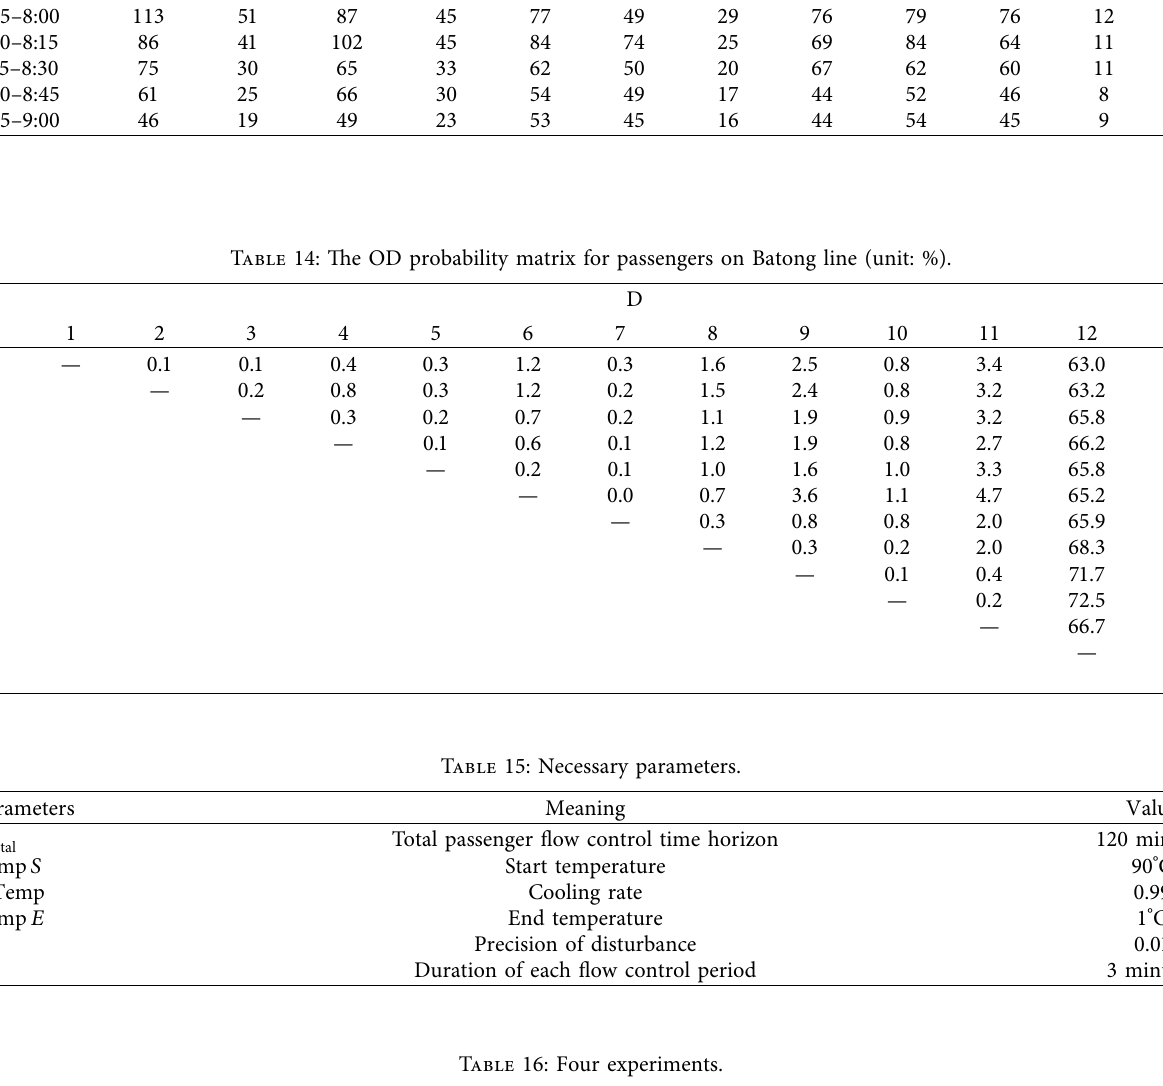
Table 13: Passenger demand of Batong line (7:00-9:00) (unit: pax/minute).